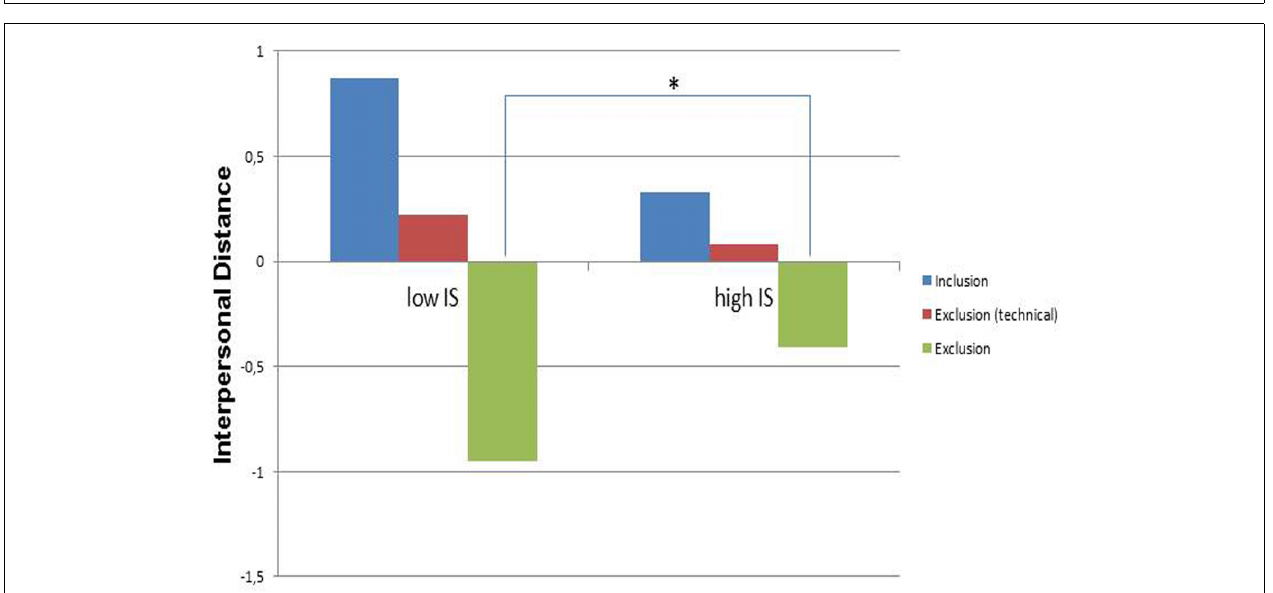
FIGURE 2 | Interpersonal distance after cyberball contrasting participants with high and low IS in the three experimental conditions ( N = 69; * p < 0.05).